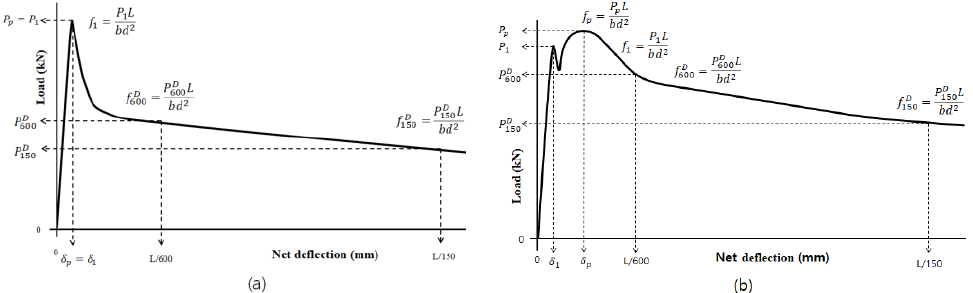
Figure 4. Definition of flexural toughness according to ASTM C1609/C1609M and KS F 2566; ( a ) when the maximum load and the first peak load match, and ( b ) when the maximum load and the first peak load are different.